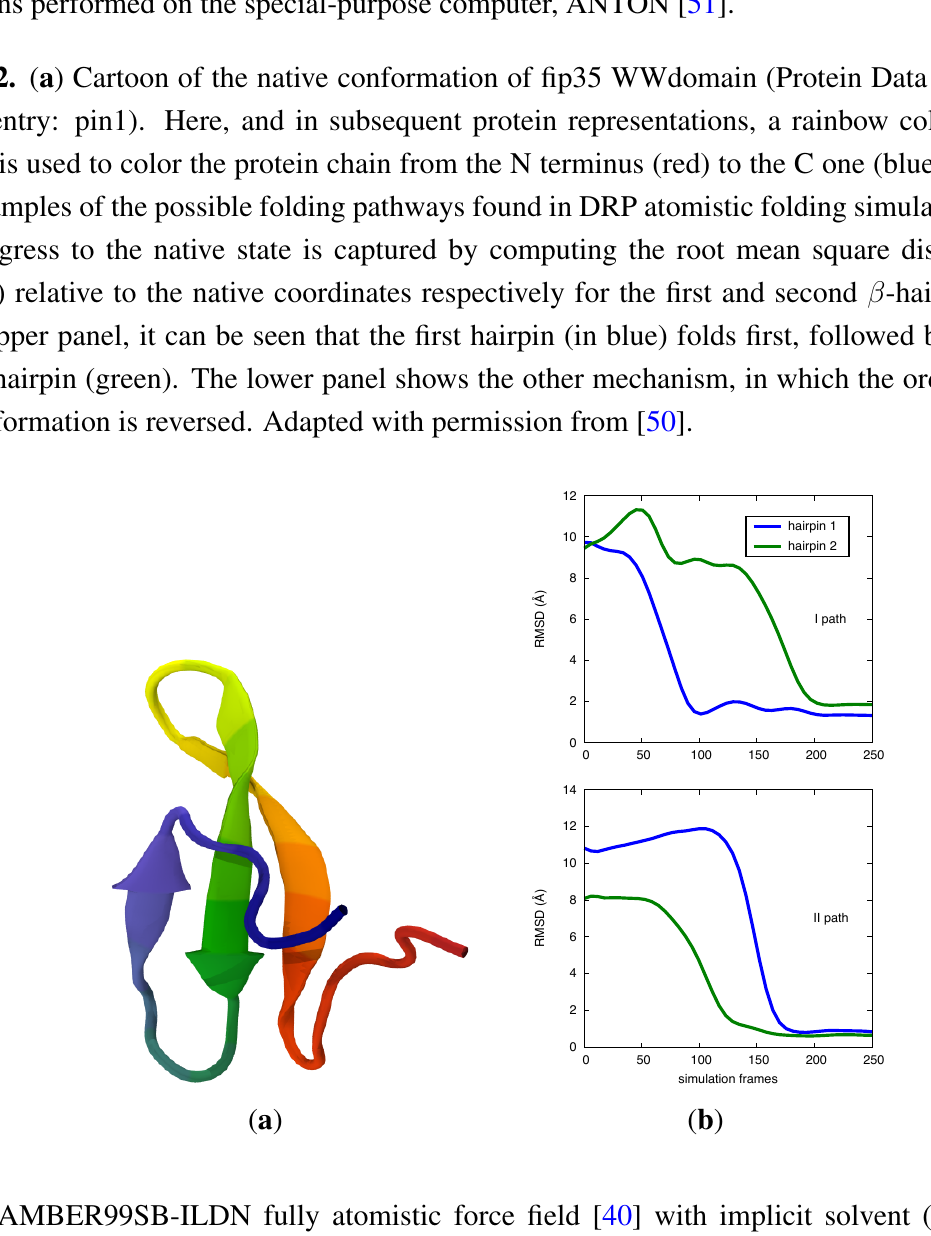
Figure 2. ( a ) Cartoon of the native conformation of fip35 WWdomain (Protein Data Bank (PDB) entry: pin1). Here, and in subsequent protein representations, a rainbow coloring scheme is used to color the protein chain from the N terminus (red) to the C one (blue). ( b